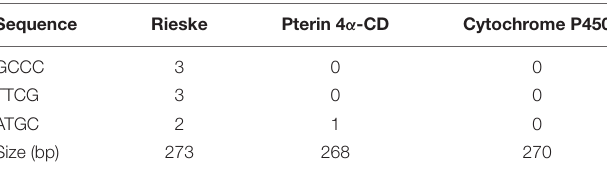
TABLE 4 | Frequency of dsRNA unique sequences.